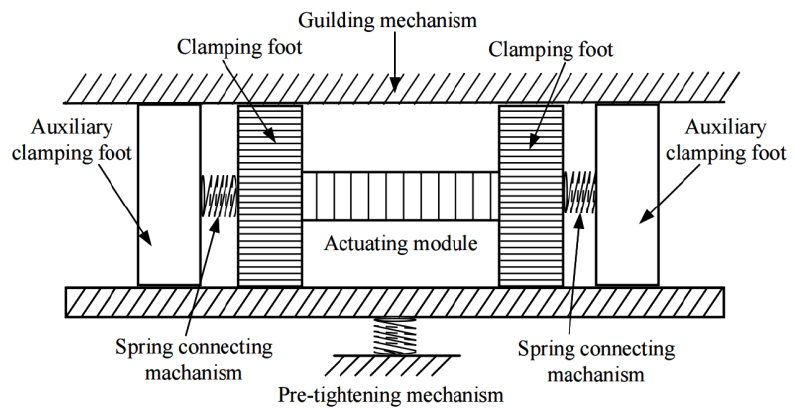
Figure 2. Structural diagram of auxiliary clamping feet inchworm piezoelectric linear motor.